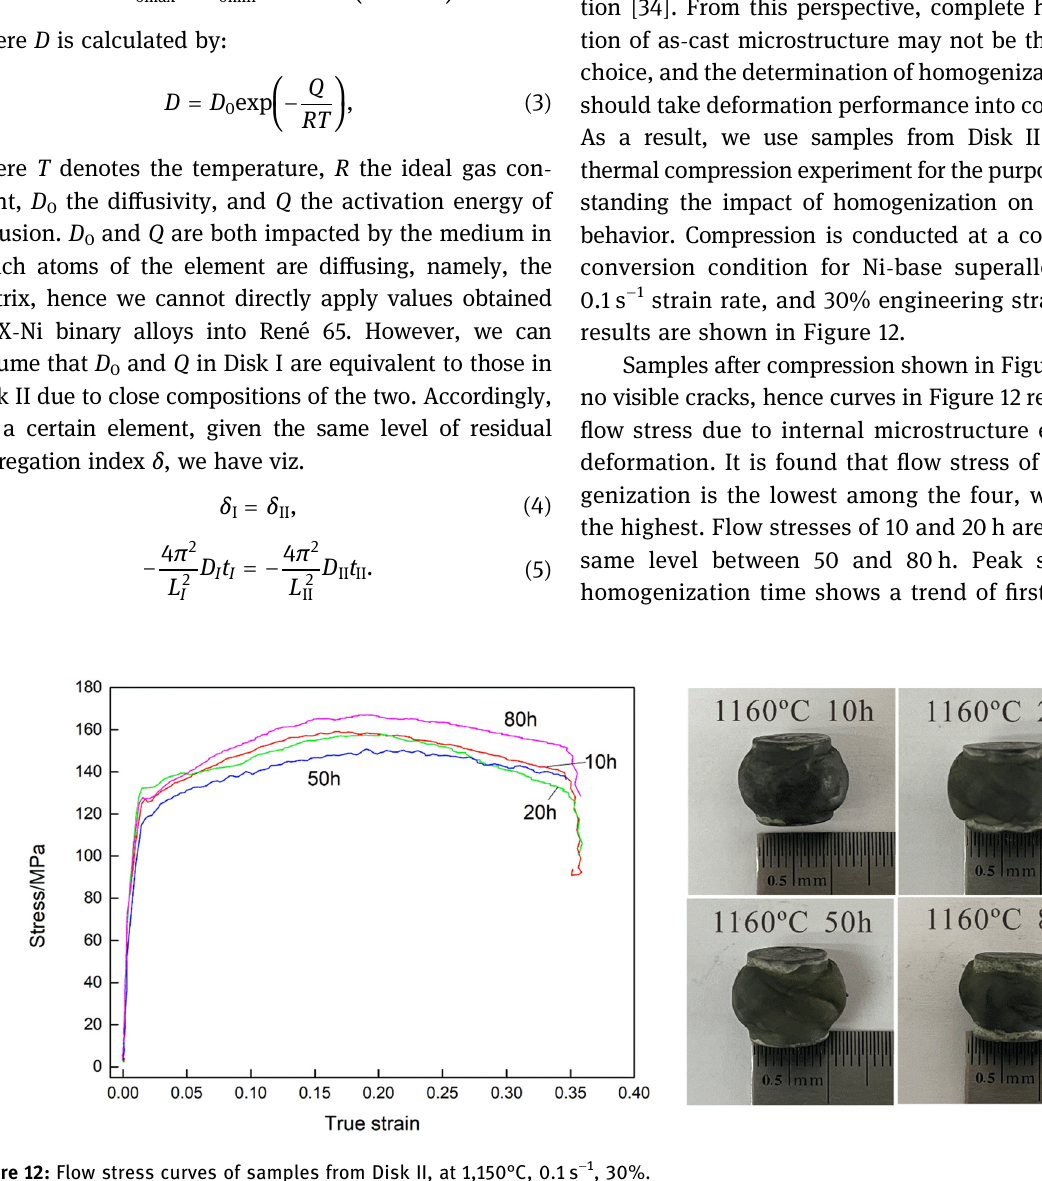
Figure 12: Flow stress curves of samples from Disk II, at 1,150°C, 0.1 s − 1 ,